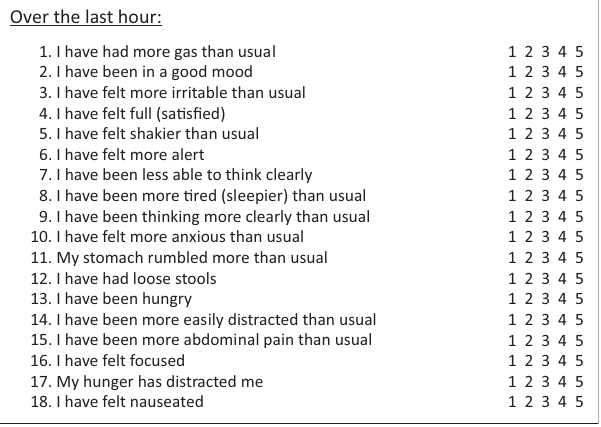
FIGURE 1: Subjective measures